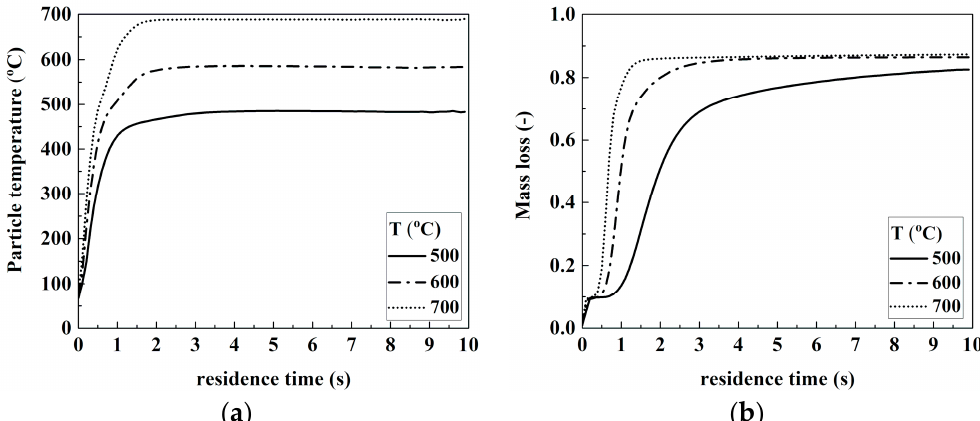
Figure 11. Theaveragethermochemicalconversionofthebiomassparticlesforthedifferenttemperatures: Figure 11. The average thermochemical conversion of the biomass particles for the different ( a ) Particle temperature; ( b ) Particle mass temperatures: ( a ) Particle temperature; ( b ) Particle mass loss.